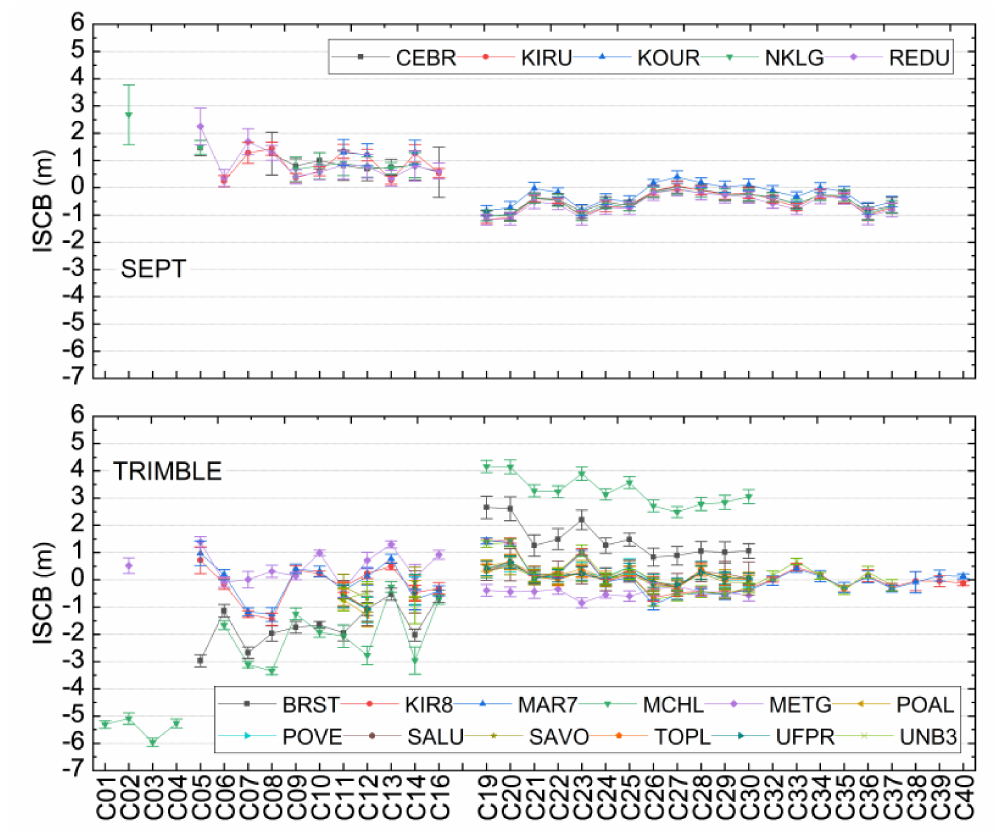
Figure 2. Average and stability of the BDS, 2 and BDS, 3 satellites’ inter, satellite code biases (ISCBs) of Septentrio and Trimble. Table 4. The average ISCBs of BDS, 2 and BDS, 3 and the inter, system bias (ISB) and standard deviation (STD) of the Septentrio and Trimble receivers